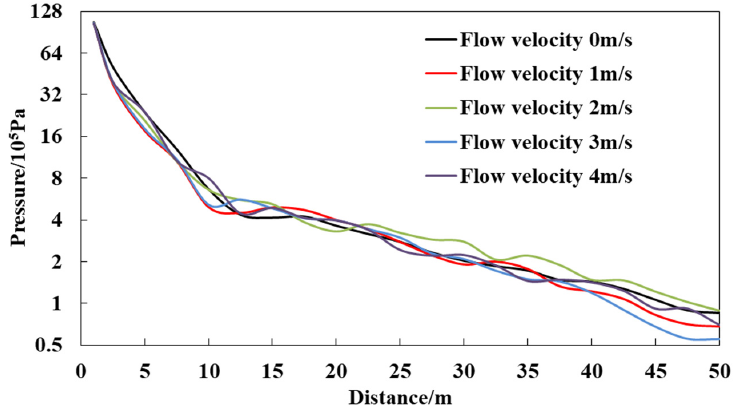
Figure 10. Transmission pattern of shock wave pressure at different flow velocities.